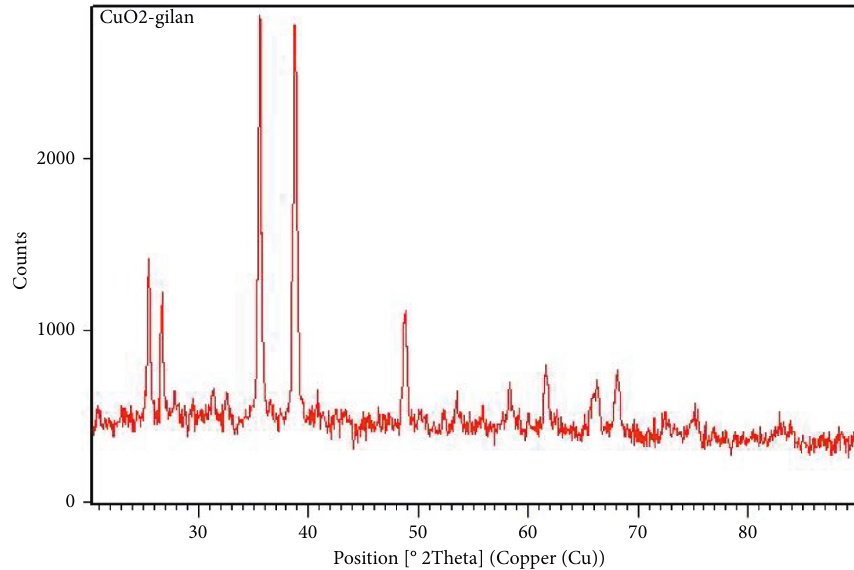
Figure 5: XRD pattern of synthesized CuO NPs using propolis (Gilan) extract.